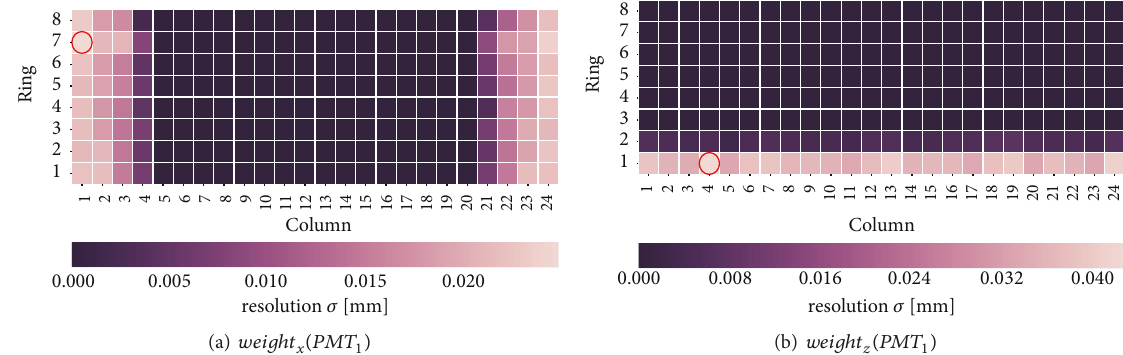
Figure 4: Weights as given by the bottleneck neuron corresponding to each PMT for (a) 𝑥 and (b) 𝑧 using the bottleneck DNN. In each heatmap, the circled PMT corresponds to the largest weight in the heatmap amongst all the 192 PMTs, indicating that it is the most heavily used PMT in the DNN during the vertex reconstruction.